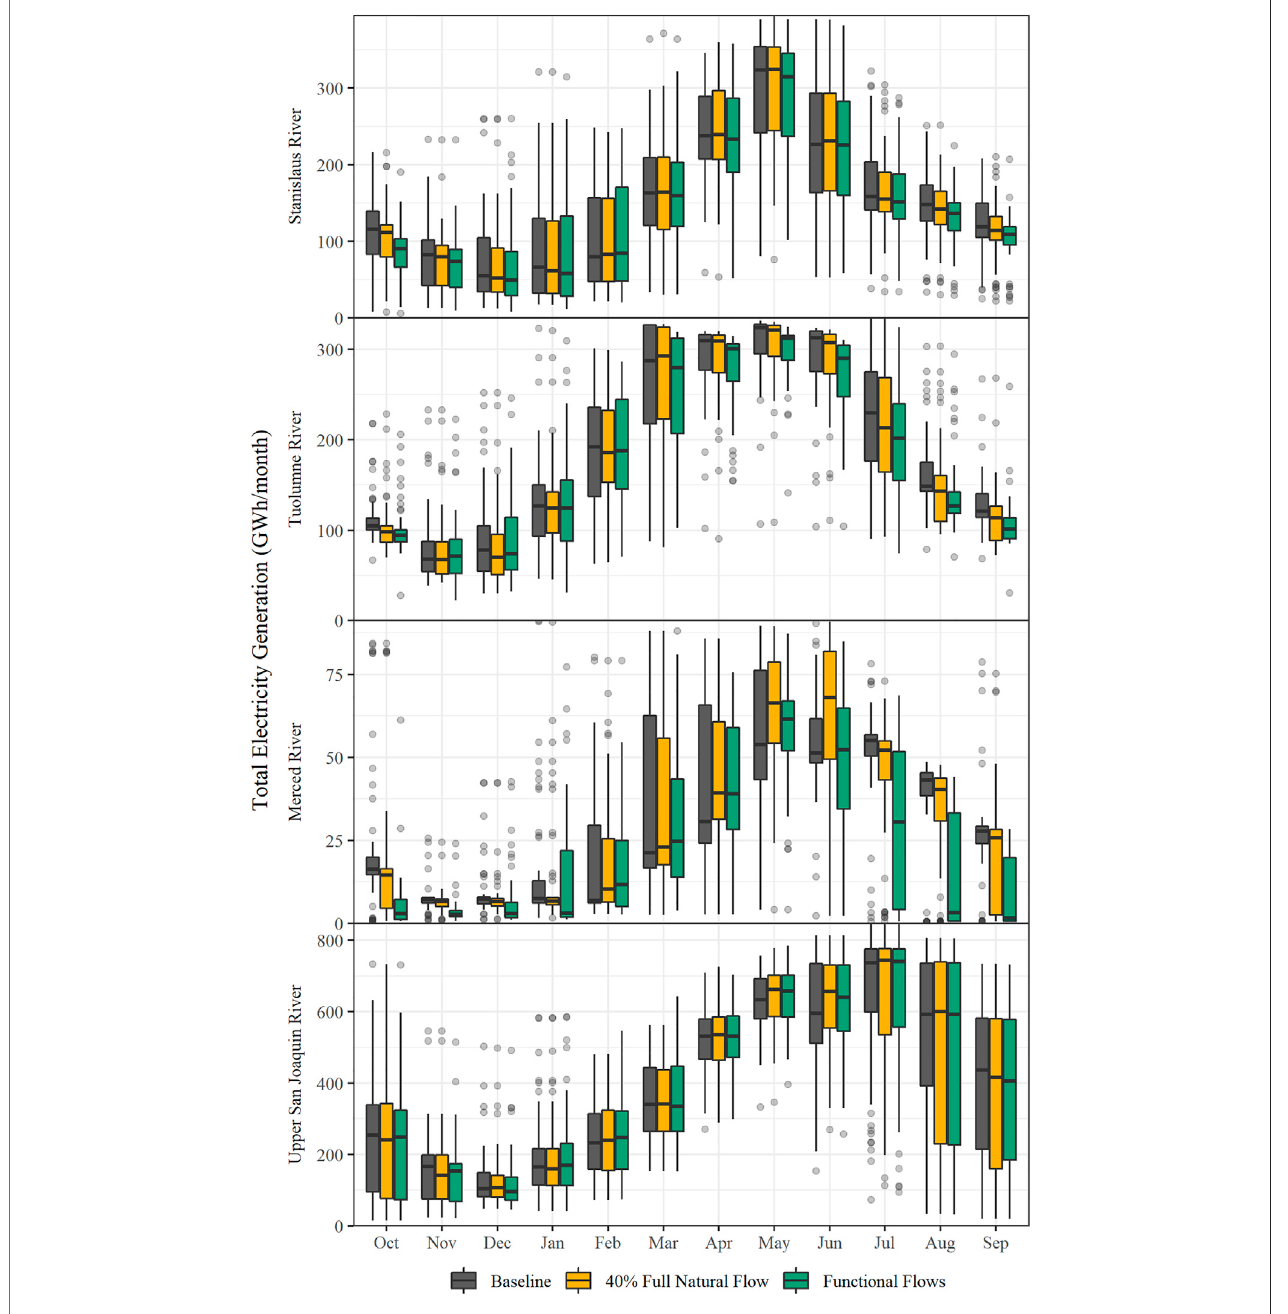
FIGURE5| Totalmonthlyhydropowerproductionforeachofthefourbasinsforthreestrategies:baseline,40%FNF,andfunctional fl ows.Notethedifferentscales.